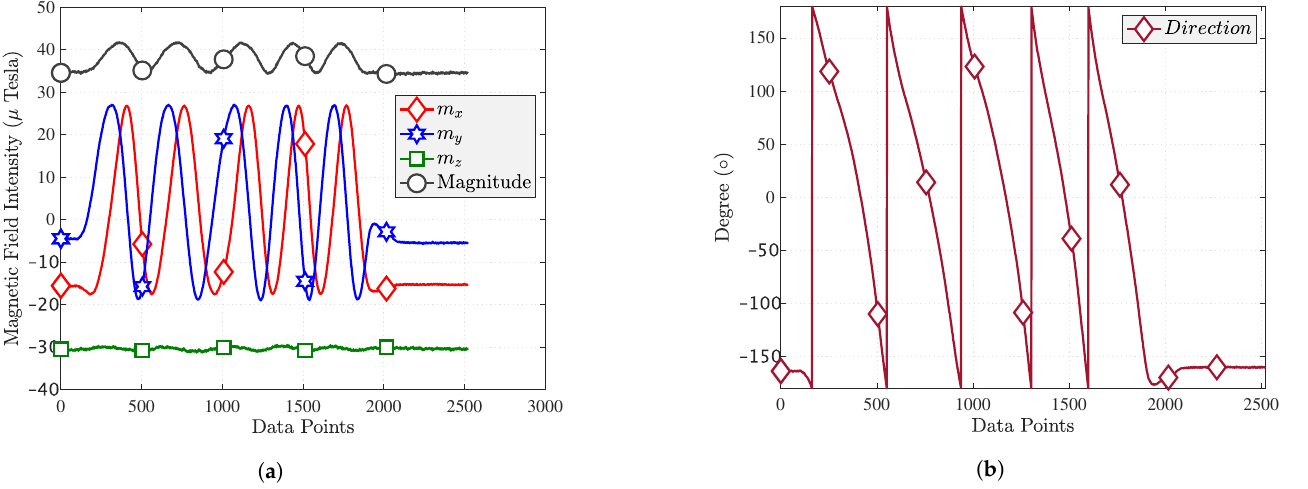
Figure 6. Smartphone rotation test: ( a ) magnetic field with rotation; ( b ) magnetic direction.